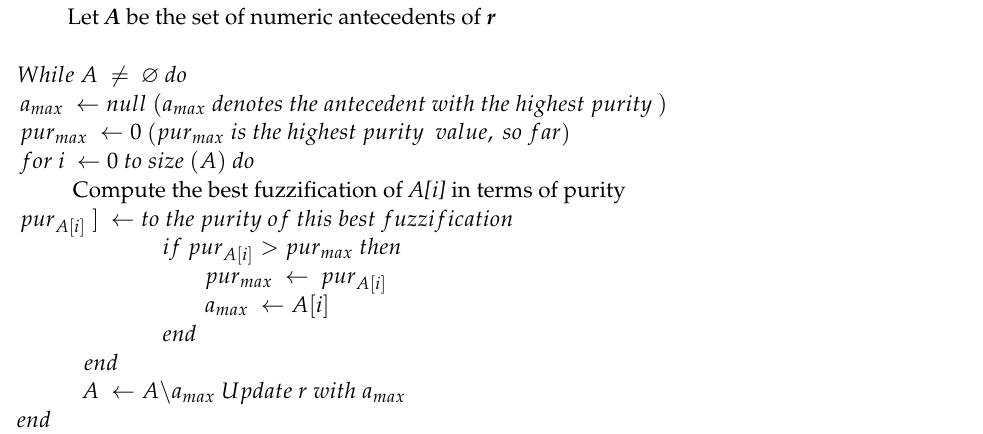
Algorithm 1: Generation of single ruler